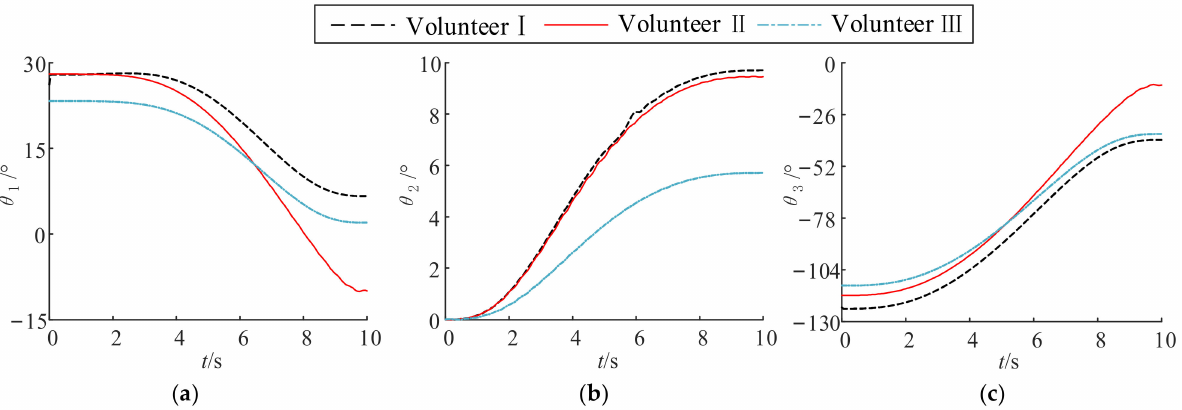
Figure 17. The participants’ joint motion curves. ( a ) The terminal θ 1 value varies with time. ( b ) The terminal θ 2 value varies with time. ( c ) The terminal θ 3 value varies with